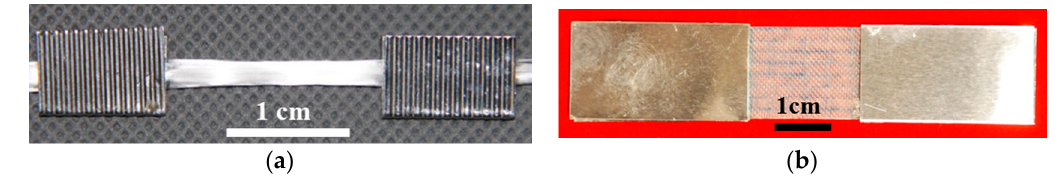
Figure 2. Prepared samples of ( a ) glass yarn and ( b ) GFRP.